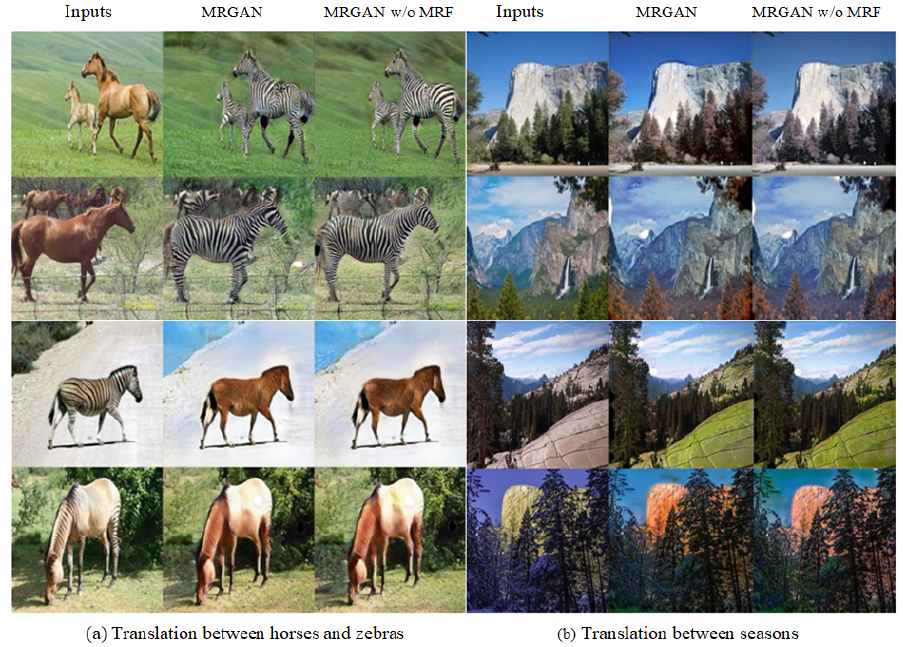
Figure 7. The effects on results using different types of inputs for the discriminator. ( a ) The migration between zebras and horses. ( b ) The conversion between winter and summer. From left to right in ( a , b ): input images, the results using random image block inputs with 70 × 70 pixels, and the results using full-image